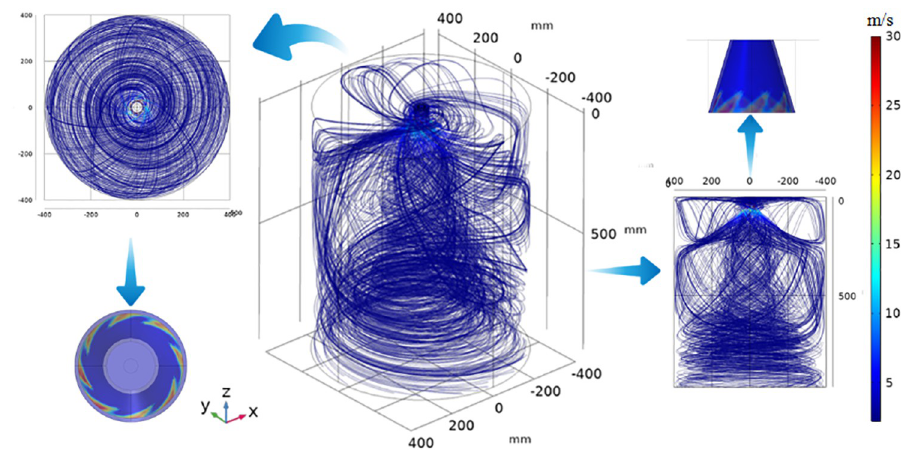
Fig 11. Simulation of velocity field of spiral spray.